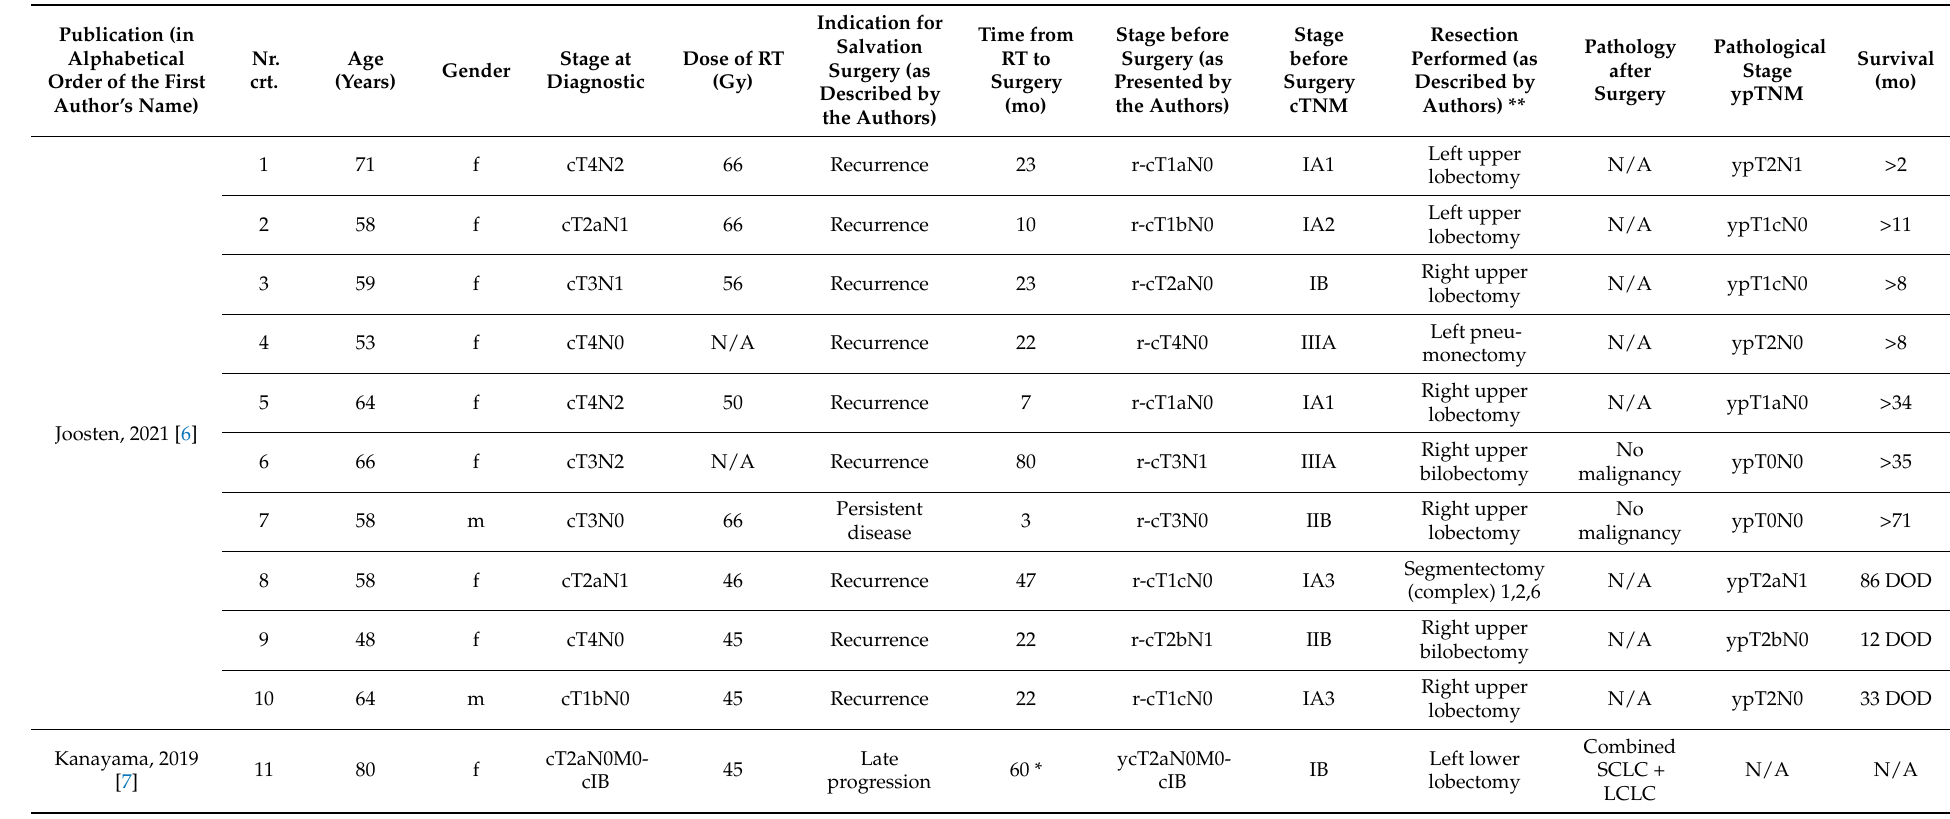
Table 1. Cases of salvage surgery for SCLC identified in the literature. All patients were confirmed with an SCLC component before any treatment (according to the published